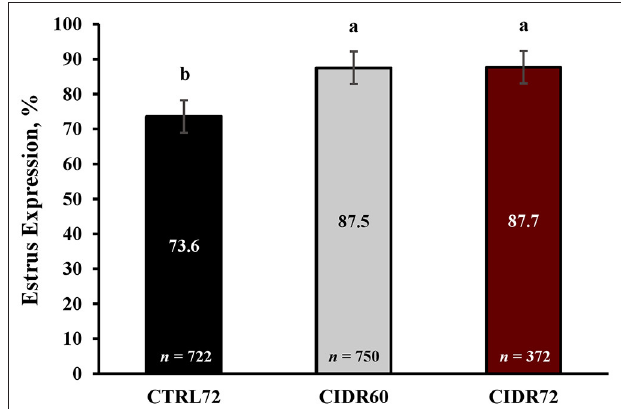
FIGURE 2 | Estrus expression by synchronization treatment. CTRL72, PG-7 7-d CO-Synch + CIDR protocol; CIDR60, same as CTRL72 but CIDR inserted on Day − 7 and TAI performed 60h after CIDR removal; CIDR72, same as CIDR60 but TAI delayed to 72h after CIDR removal; Estrus patches, Breeding indicator patches (Estrotect; Rockway Inc., Spring Valley, WI) were applied to all heifers at CIDR removal and were evaluated for activation at their respective time of TAI. Least square means ± SEM are reported. a,b Rows with different superscripts differ ( P ≤